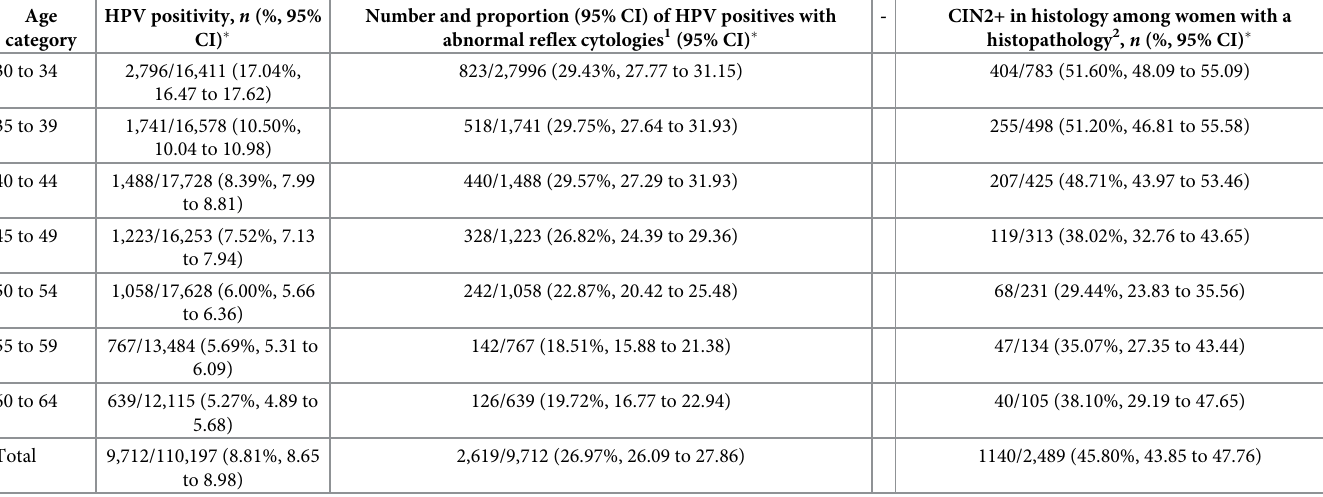
Table 3. Primary HPV policy screening and histopathology outcomes among 110,197 women who attended PP (organized screening). Age category